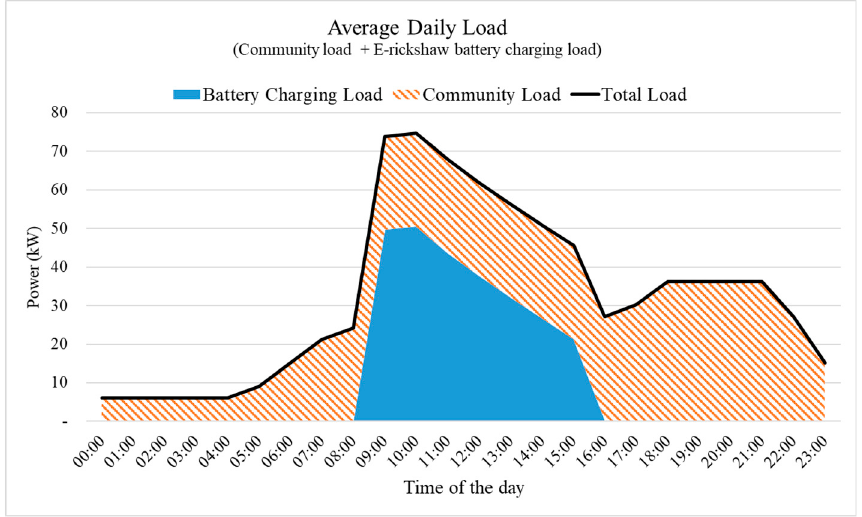
Figure 8. Average daily total load of the system. The total is the sum of community load and e-rickshaw battery charging load. The annual demand was calculated to be 256,595 kWh.